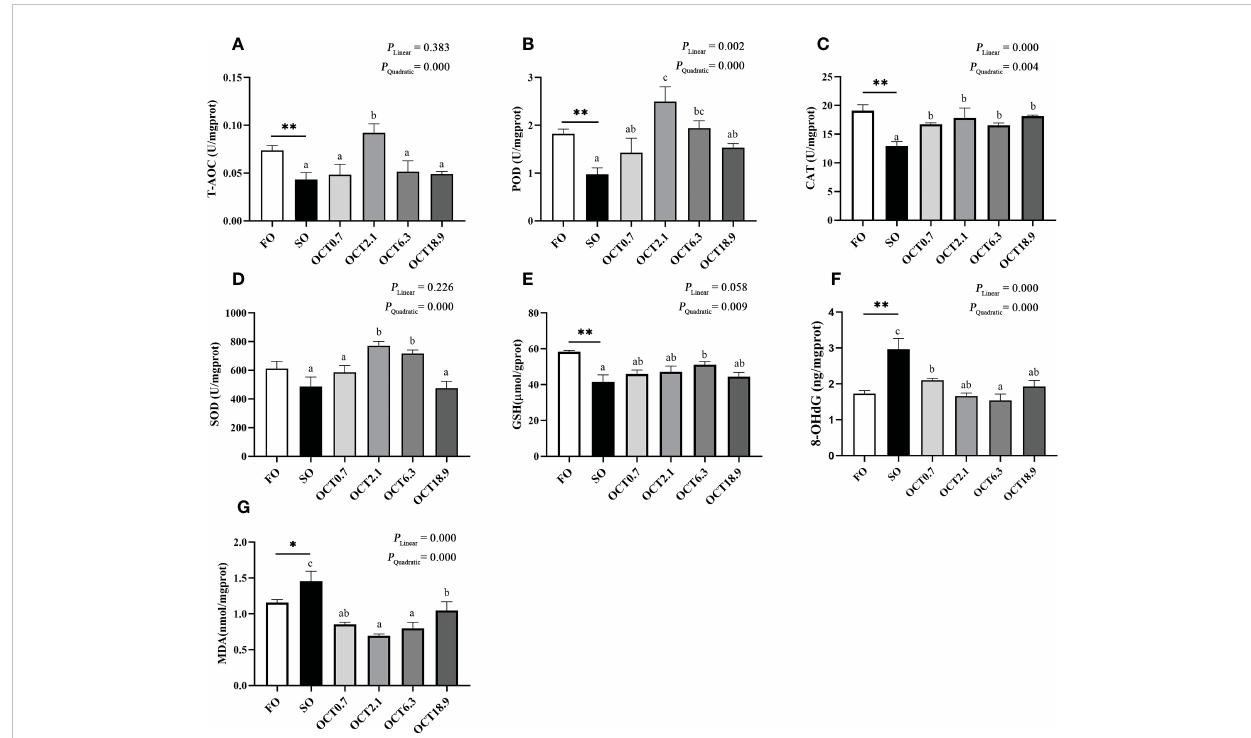
FIGURE 5 Effects of supplemental octanoate on hepatic antioxidant capacity of large yellow croaker. (A) Total antioxidant capacity, (B) Peroxidase activity, (C) Catalase activity, (D) Superoxide dismutase activity, (E) Reduced glutathione contents, (F) 8-OHdG contents, (G) Malondialdehyde contents. Values were means (n = 3) with their standard errors represented by vertical bars. ∗ represent a signi fi cant difference of P < 0.05 between the SO group and the FO group. ∗∗ represent a signi fi cant difference of P < 0.01 between the SO group and the FO group. Different letters show signi fi cant difference ( P < 0.05) among OCT treatment groups. Linear trend and Quadratic trend were analyzed by orthogonal polynomial